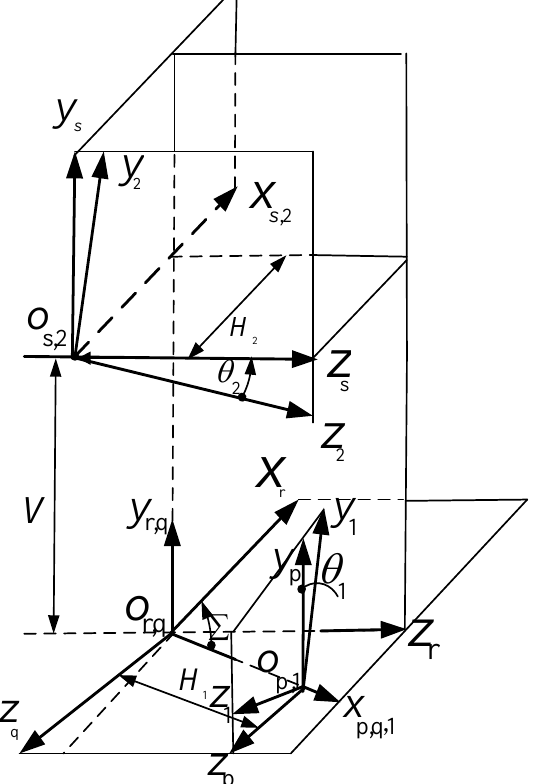
Figure 1. Generation of Hypoid Gear Coordinate System.